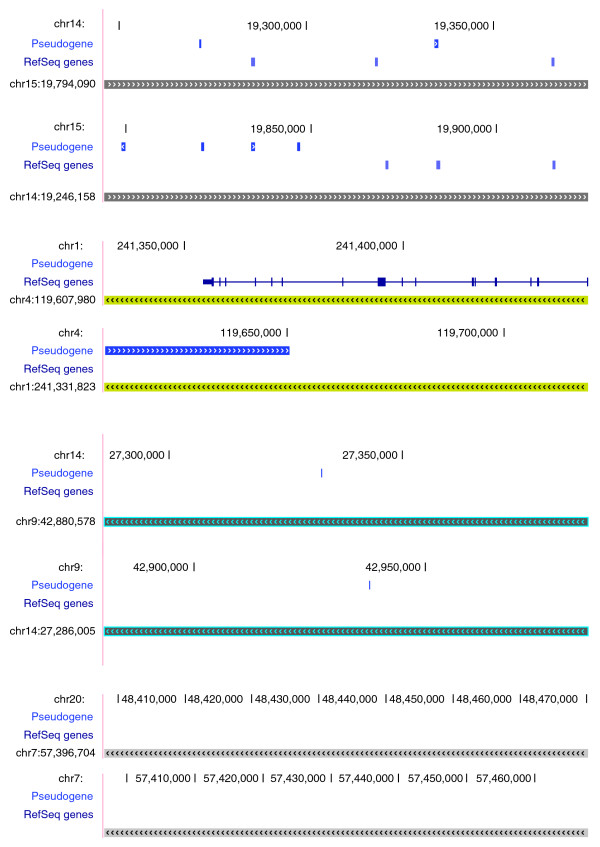
Gene and pseudogene annotations in four pairs of human SDs with known duplication directions. The parental locus of each pair is depicted first, followed immediately by its derivative.